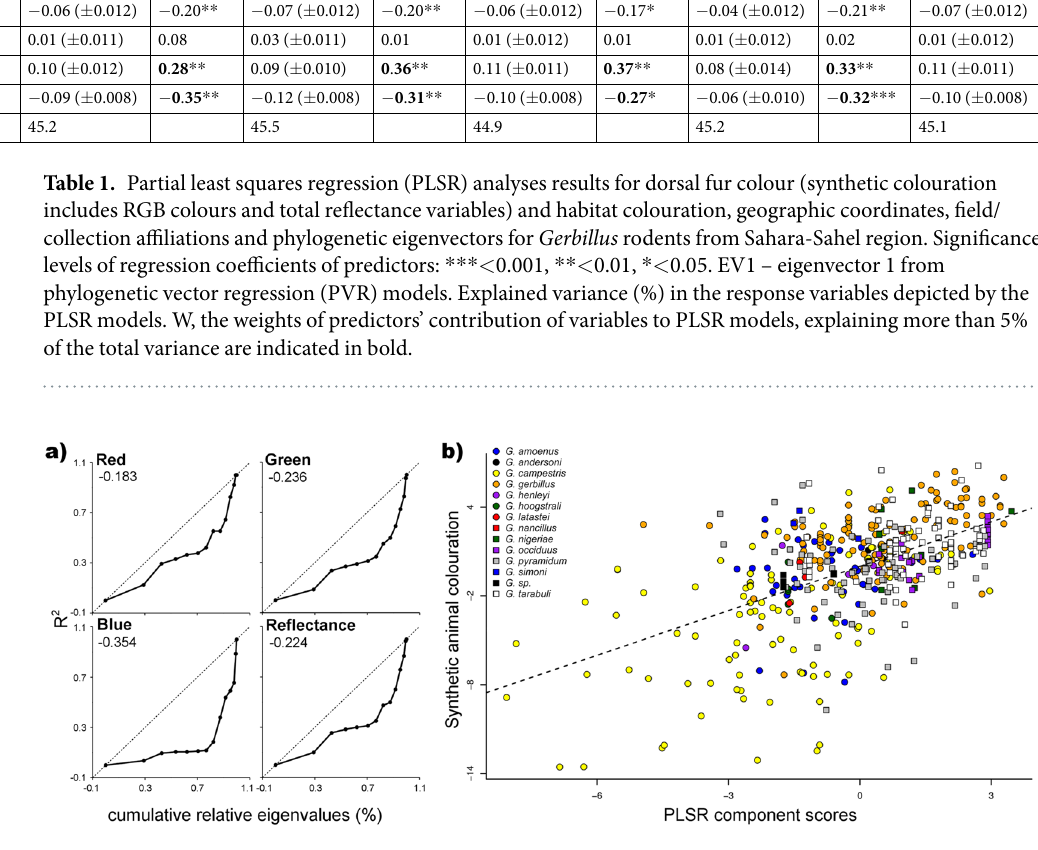
Figure 3. ( a) Closely related species are less similar in colouration than expected, as indicated by negative mean deviation from phylogenetic signal-representation (PSR) curves. PSR curves for animal fur colouration (RGB and total reflectance) were derived from phylogenetic vector regression (PVR) analysis by sequentially including 12 eigenvectors. R 2 describes the amount of the variance explained by the phylogenetic eigenvectors. Dashed lines represent patterns under Brownian motion evolution. Mean differences between R 2 and eigenvalues, a measure of the phylogenetic signal, are indicated. ( b) Animal colouration followed the colouration of the environment inhabited by individuals. Habitat carries a positive, and latitude a negative, load to the relationship between the partial least-squares regression (PLSR) component scores and synthetic (including variation in RGB colour spectrum and total reflectance) variable of animal fur colouration. PLSR component scores represent the position of sampling units (individual specimens) along an axis composed of the predictor variables of habitat colouration (RGB and total reflectance), geographic coordinates, museum/ field affiliation and phylogenetic signal (eigenvector scores from phylogenetic vector analyses, PVR).